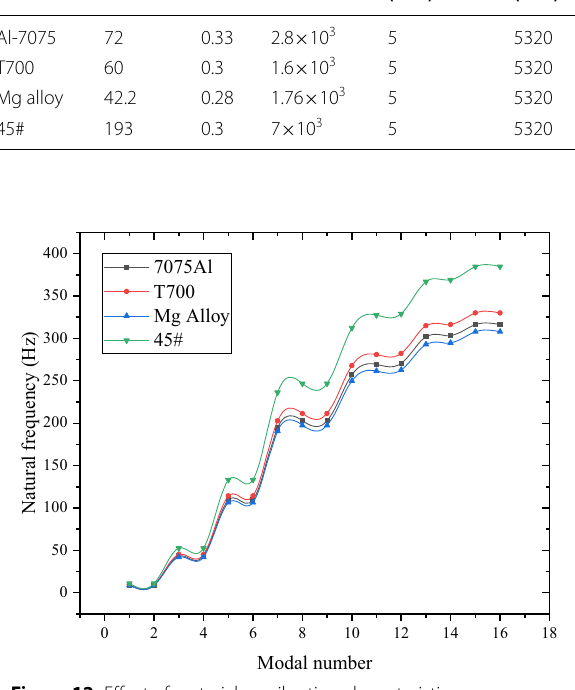
Figure 12 Effect of material on vibration